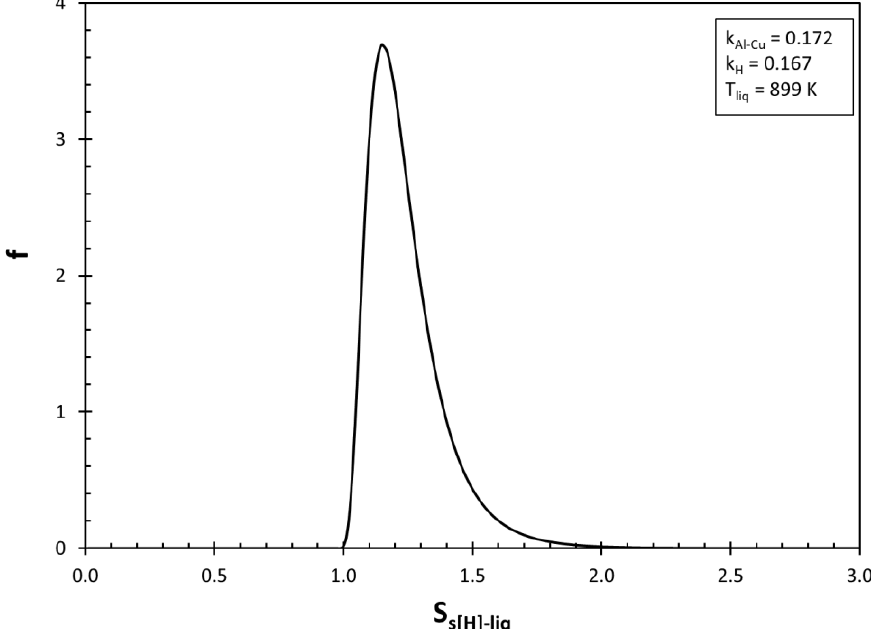
Figure 5. The lognormal distribution for hydrogen supersaturation, as calculated by using Equation (7) and temperature distribution in Figure 3. The parameters used in the calculations are also indicated.